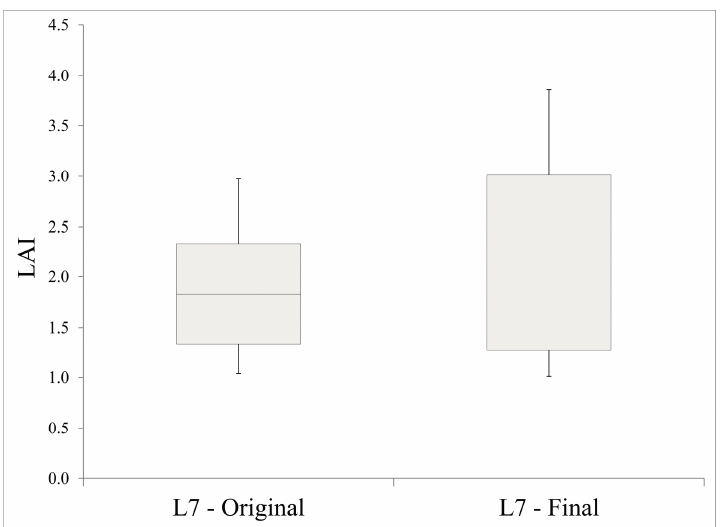
Figure 11. Appomattox, Virginia 1 km 2 area original LAI (L7-Original) comparison